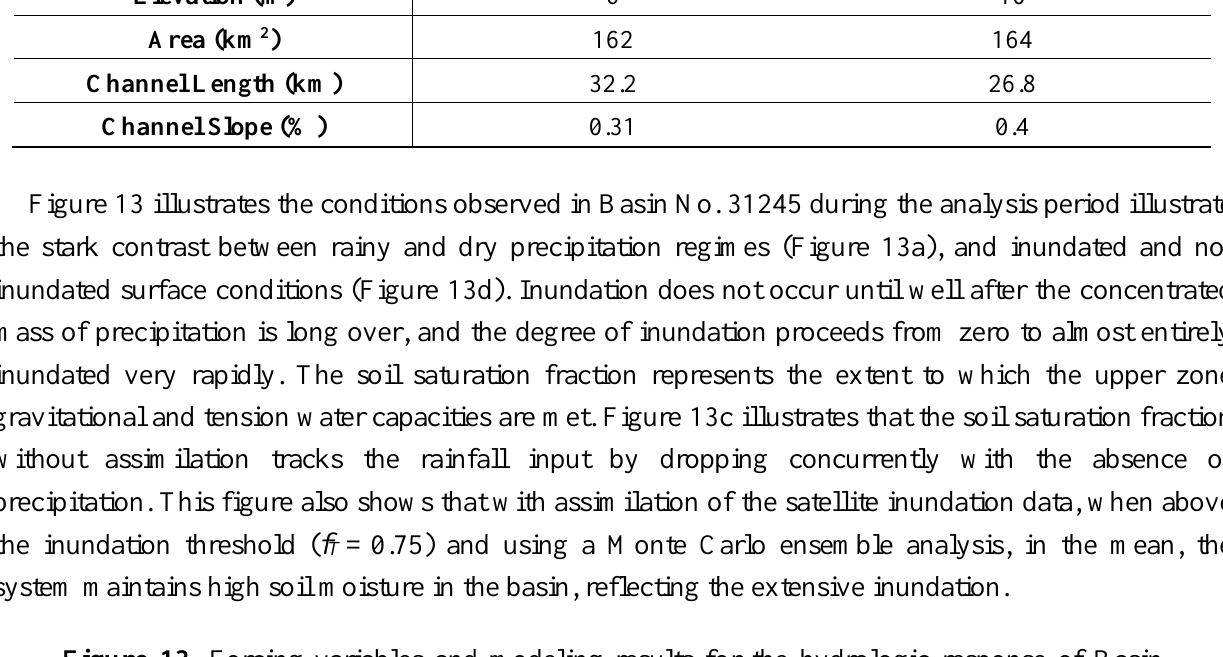
Figure 13. Forcing variables and modeling results for the hydrologic response of Basin No. 31245: ( a ) precipitation, ( b ) the 6-hr Flash Flood Guidance value (in mm/6hrs), ( c ) soil moisture saturation fraction, and ( d ) the fraction